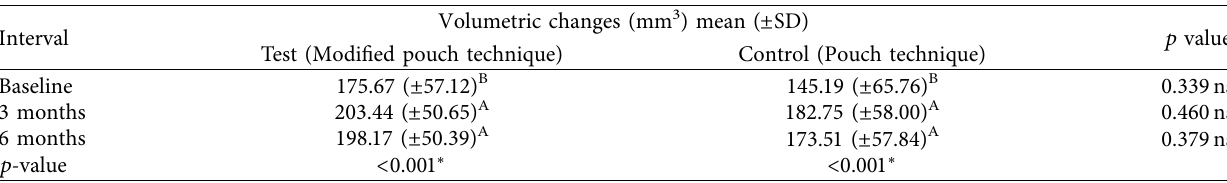
Table 1: Mean and SD values for comparison in volumetric soft tissue changes (mm 3 ) between both groups at different study periods.